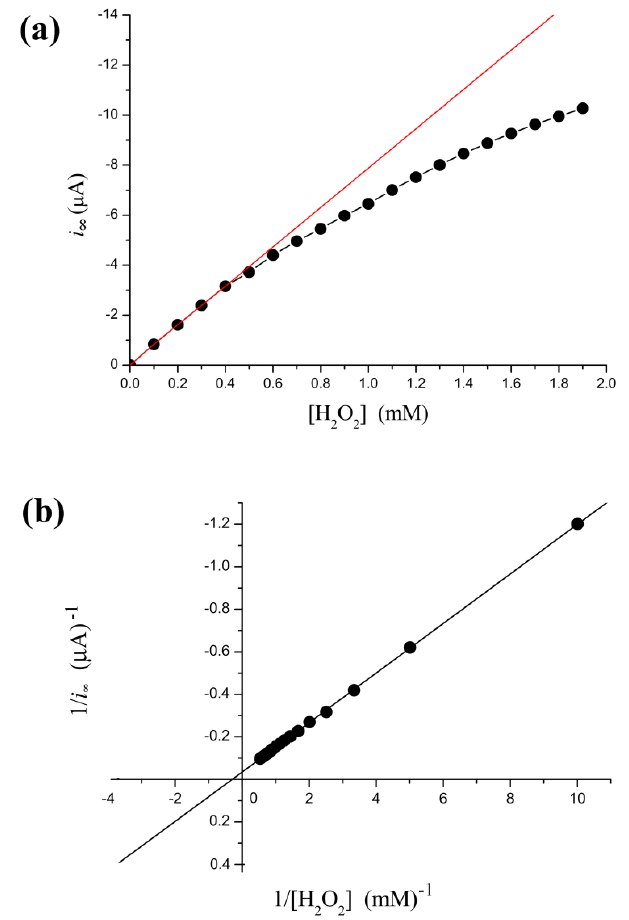
Figure 2. Effect of the concentrations of H ( a ) Lineweaver-Burk plot. ( b ) Michaelis-Menten plot. The initial four points are fitted by a calibration line (red line) with the slopes of − 7.86 and intercept of − 0.025 ( r = − 0.999; p < 0.0001).